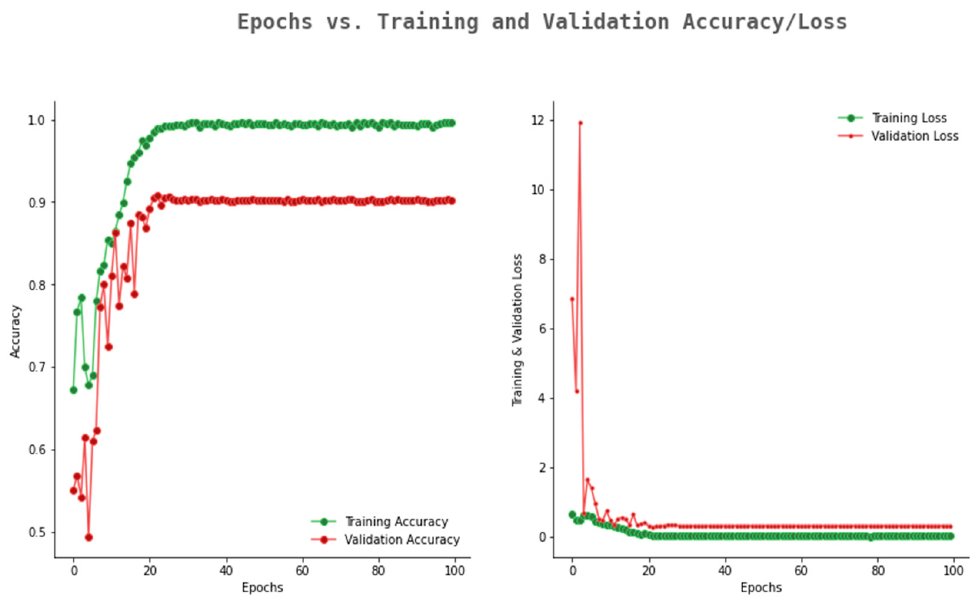
Figure 11. Accuracy and loss graph of ResNet101.